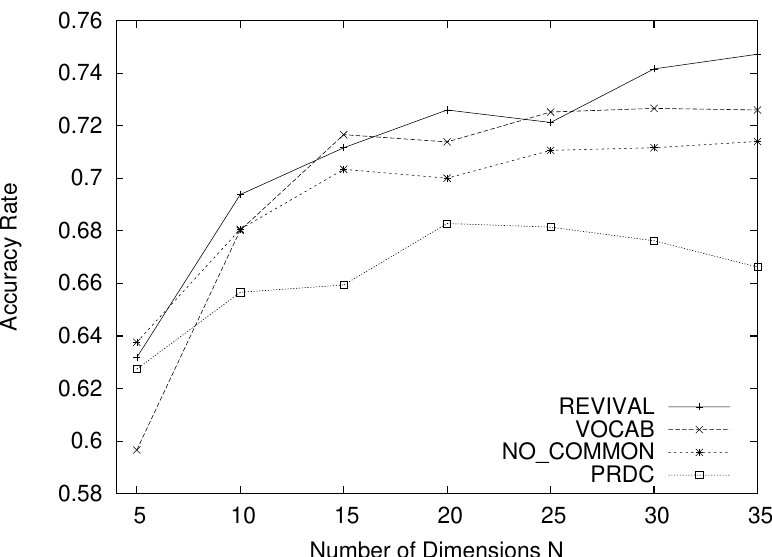
Figure 5. Accuracy rate for UC Merced land use dataset: PRDC.